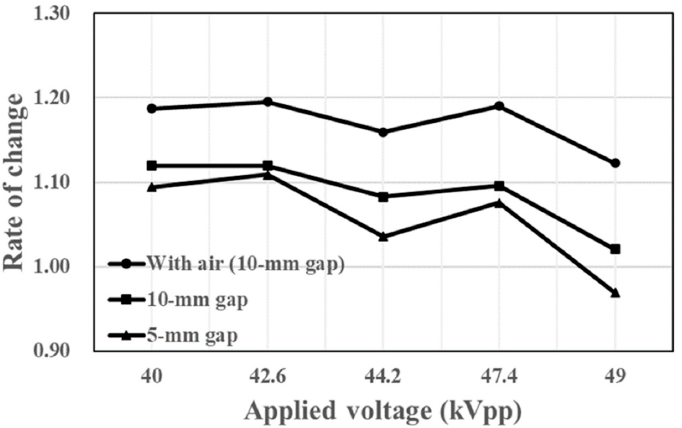
Figure 6. Dependence of HM removal rates on applied voltages for three conditions. The change rates were observed by analyzing brightness changes at the HM removal positions in photographs taken before and after the plasma treatment for 60 s.